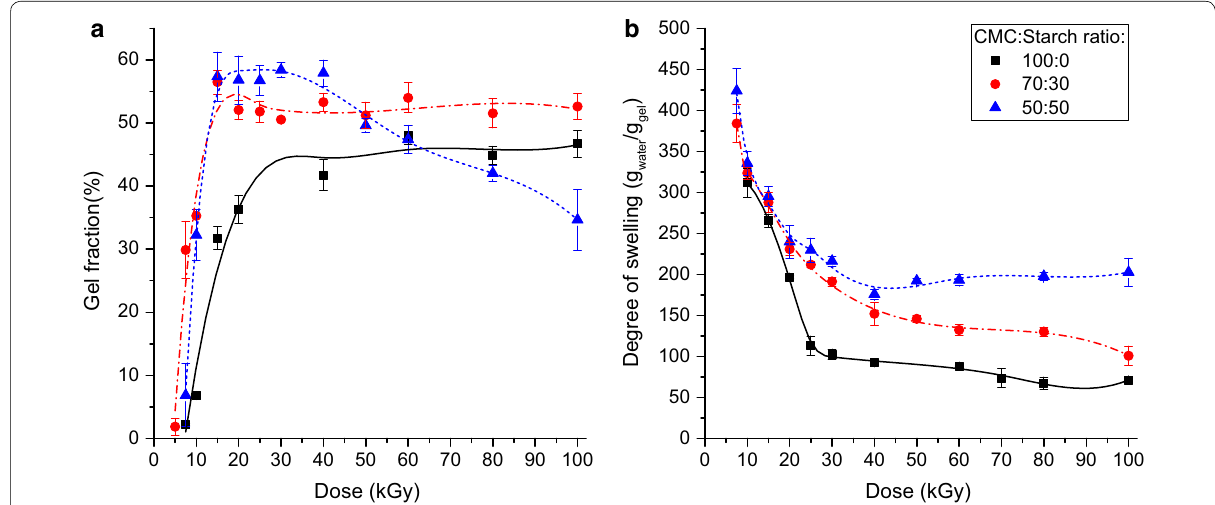
Fig. 4 The effect of the absorbed dose on the gel fraction ( a ) and on the degree of swelling ( b ) of various CMC/starch gels (20 w/w%